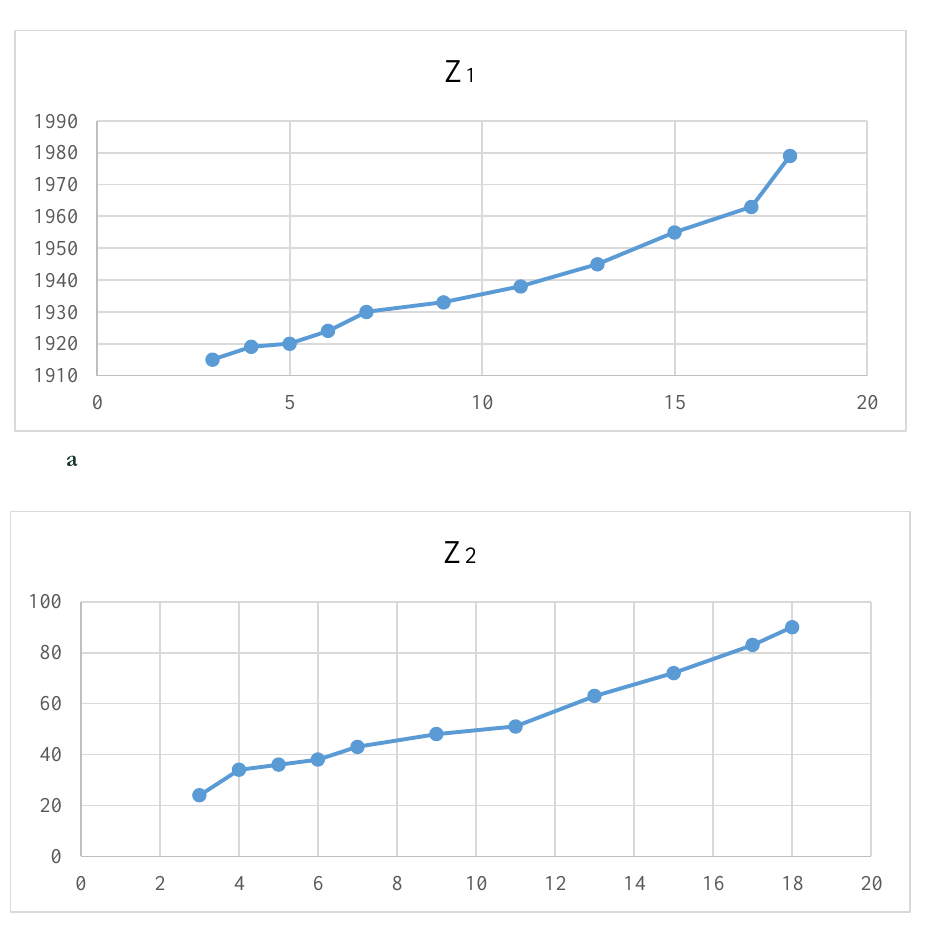
Fig. 3. The effect of each of the problem parameters on the elapsed